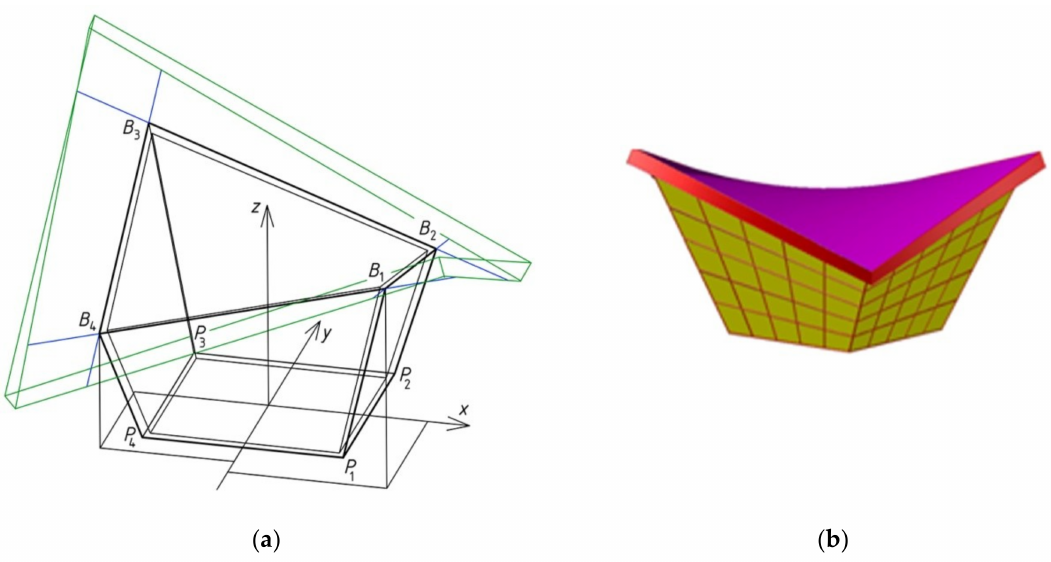
Figure 26. Two models presenting: ( a ) the thickness of roof and elevations; and ( b ) the regular pattern on